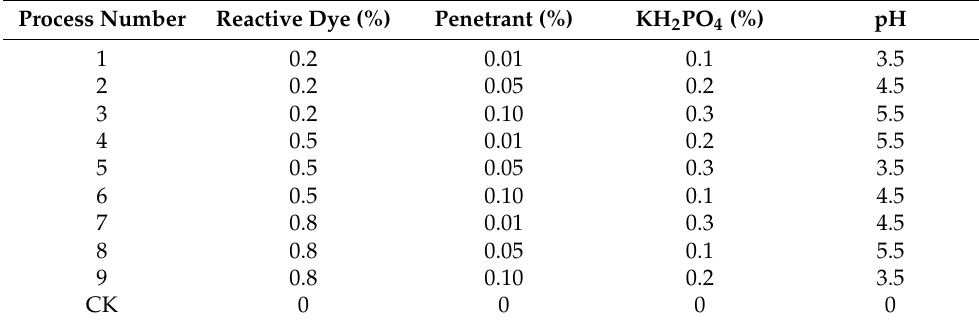
Table 1. L 9 (3) 4 orthogonal experimental